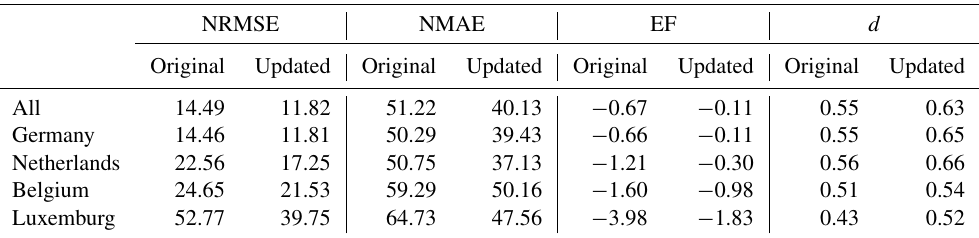
Table 2. Performance assessment of the original and the updated model by comparing annual averaged total columns. NRMSE, NMAE, EF, and d are calculated using in situ measurements and modeled results.